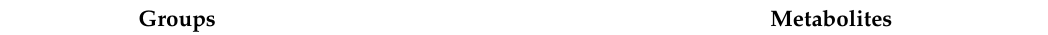
Table 4. Metabolites that responded to drug treatments according to Venn diagram comparison in U373 cell